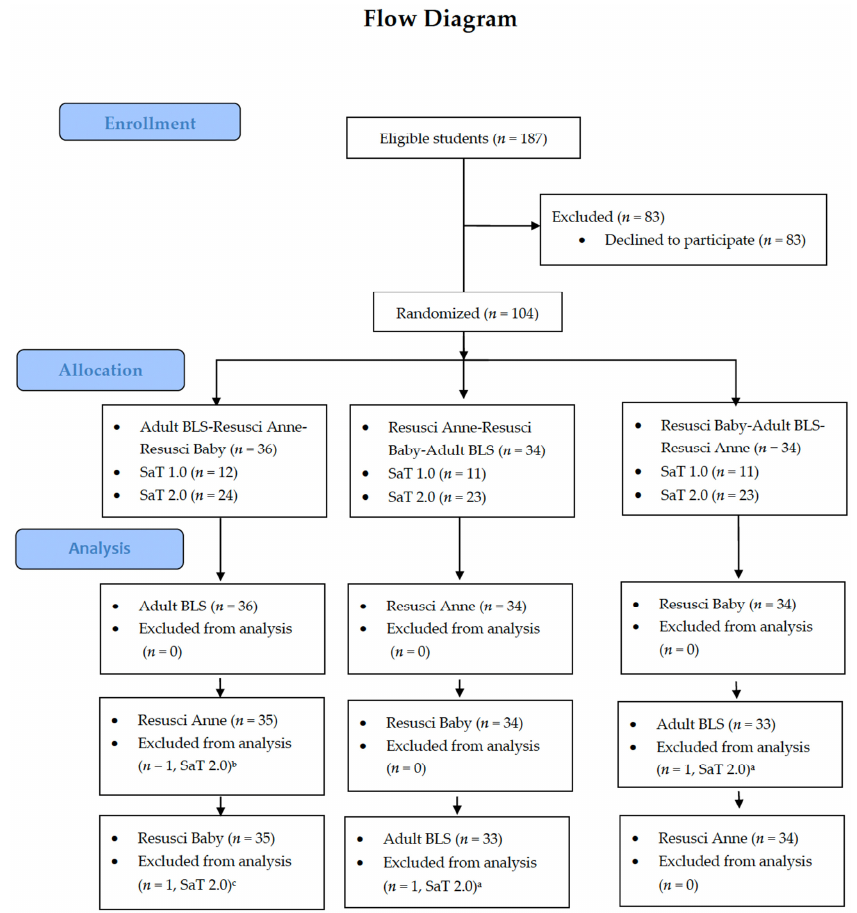
Figure 1. Flow chart showing the inclusion of study participants and allocation to three groups with sequential use of mannequins ( n = 187). SaT: student as Teacher, BLS: Basic Life support; a Not correct technique of BLS (not pinched nose) in all attempts on the mannequin; b Not correct technique of BLS (not head tilt) in all attempts on the mannequin; c Not correct technique of BLS (no neutral head position) in all attempts on the mannequin.